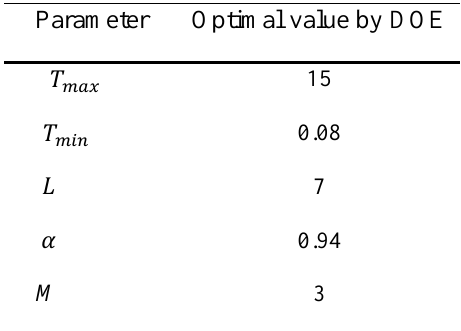
Table 9. Optimal values for minimization of the computational time of UA-CSLP case